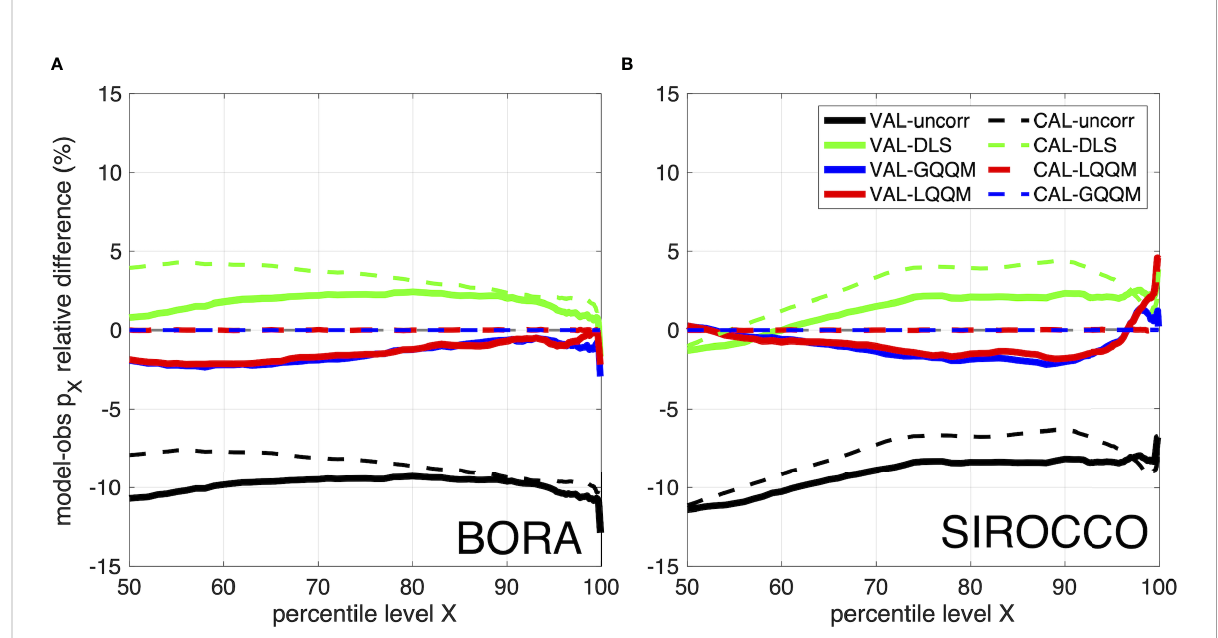
FIGURE 4 Comparison of different wind forcing calibration strategies for Bora (A) and Sirocco (B) . Model-observation ensemble X th percentile p X relative difference (%) for percentiles from 50 th to 99.9 th : without correction (uncorr), after directional linear regression scaling (DLS), after global QQM scaling (GQQM) and after local QQM scaling (LQQM). Dashed lines represent values during the wind calibration period (CAL- labels in legend), solid lines during wind validation period (VAL- labels in